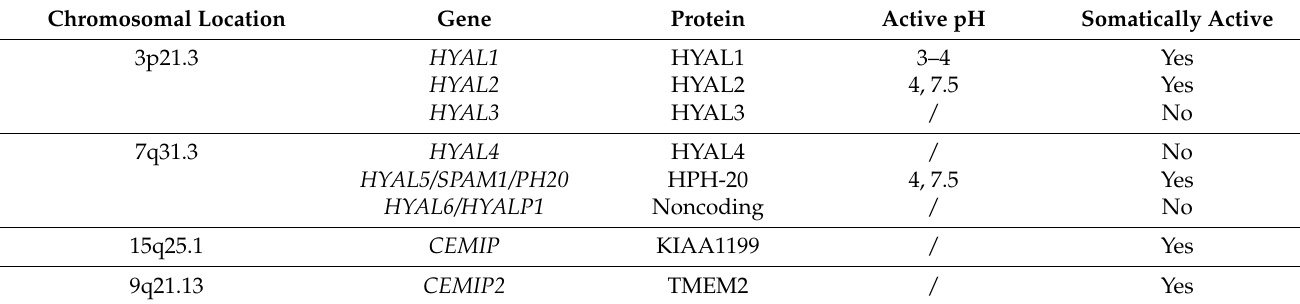
Table 1. Summary of the human hyaluronidases. This table details the chromosomal location, coded protein, active pH, and somatic activity of each human hyaluronidase gene Chromosomal Location